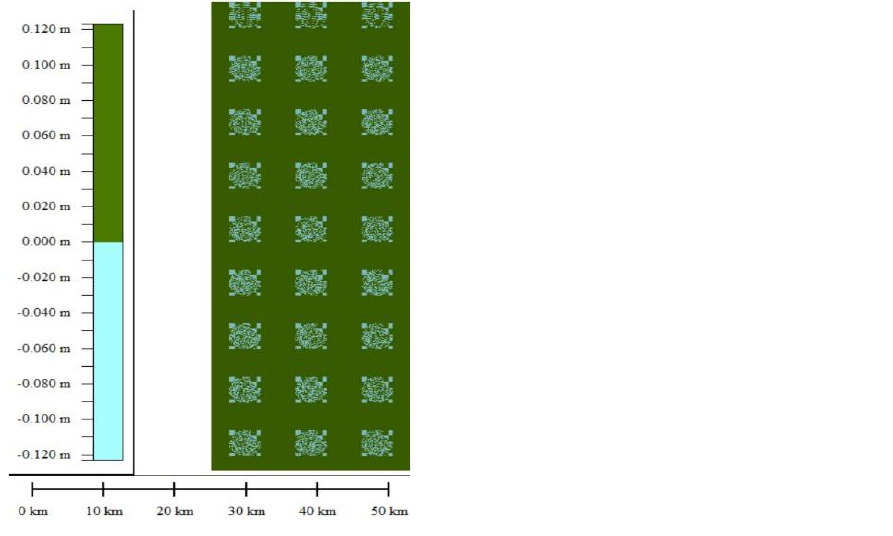
Figure 11. Differences in Z value (elevation) in watermarked DEM and Host DEM. Table 6. Results of Experiment 1 (DCT technique).